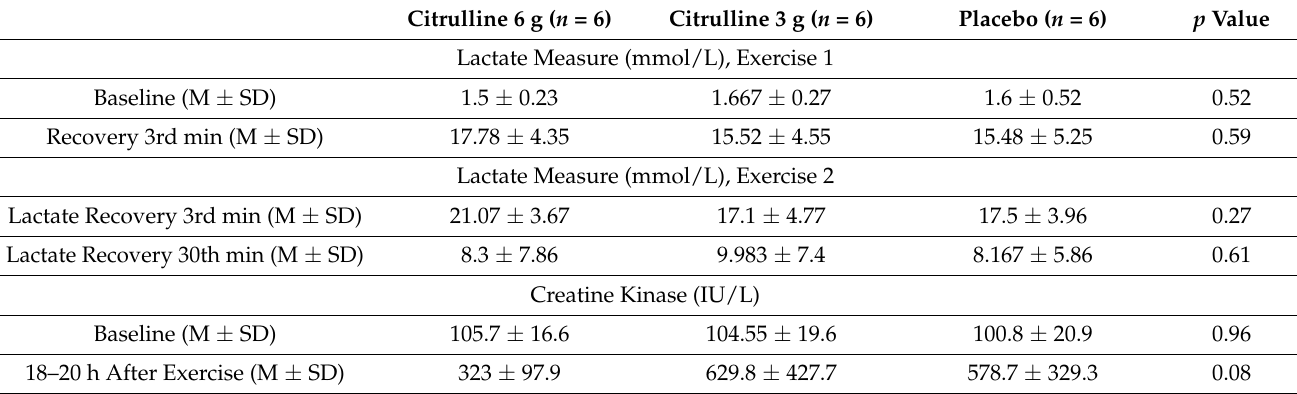
Table 3. Biochemical parameters for all groups before and after the field-based soccer-specific